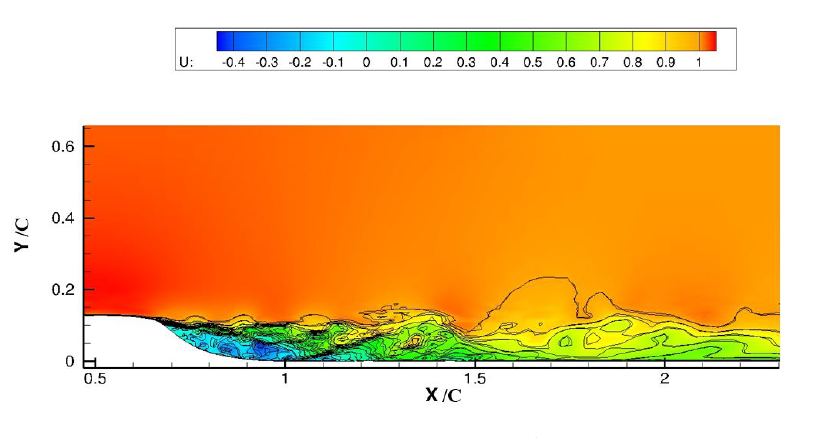
Figure 7. Instantaneous u-velocity.